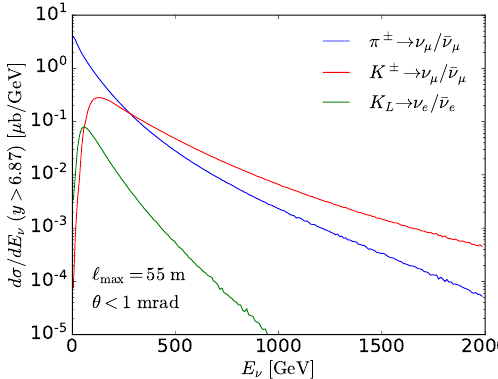
Figure 11 . The (cid:23) (cid:22) + (cid:22) (cid:23) (cid:22) energy distributions from charged pions (blue) and kaons (red) and the (cid:23) e + (cid:22) (cid:23) e energy distributions from K L semileptonic decays (green) for forward neutrinos ( (cid:17) > 6 : 87) p from the decay of mesons produced in pp interactions at s = 14 TeV, considering those mesons whose decay occurs within 55 m of the interaction point and whose momentum lies within an angle of (cid:18) < 1 mrad from the beam axis. The meson energy and rapidity distributions are evaluated using the parametrization of Koers et al.